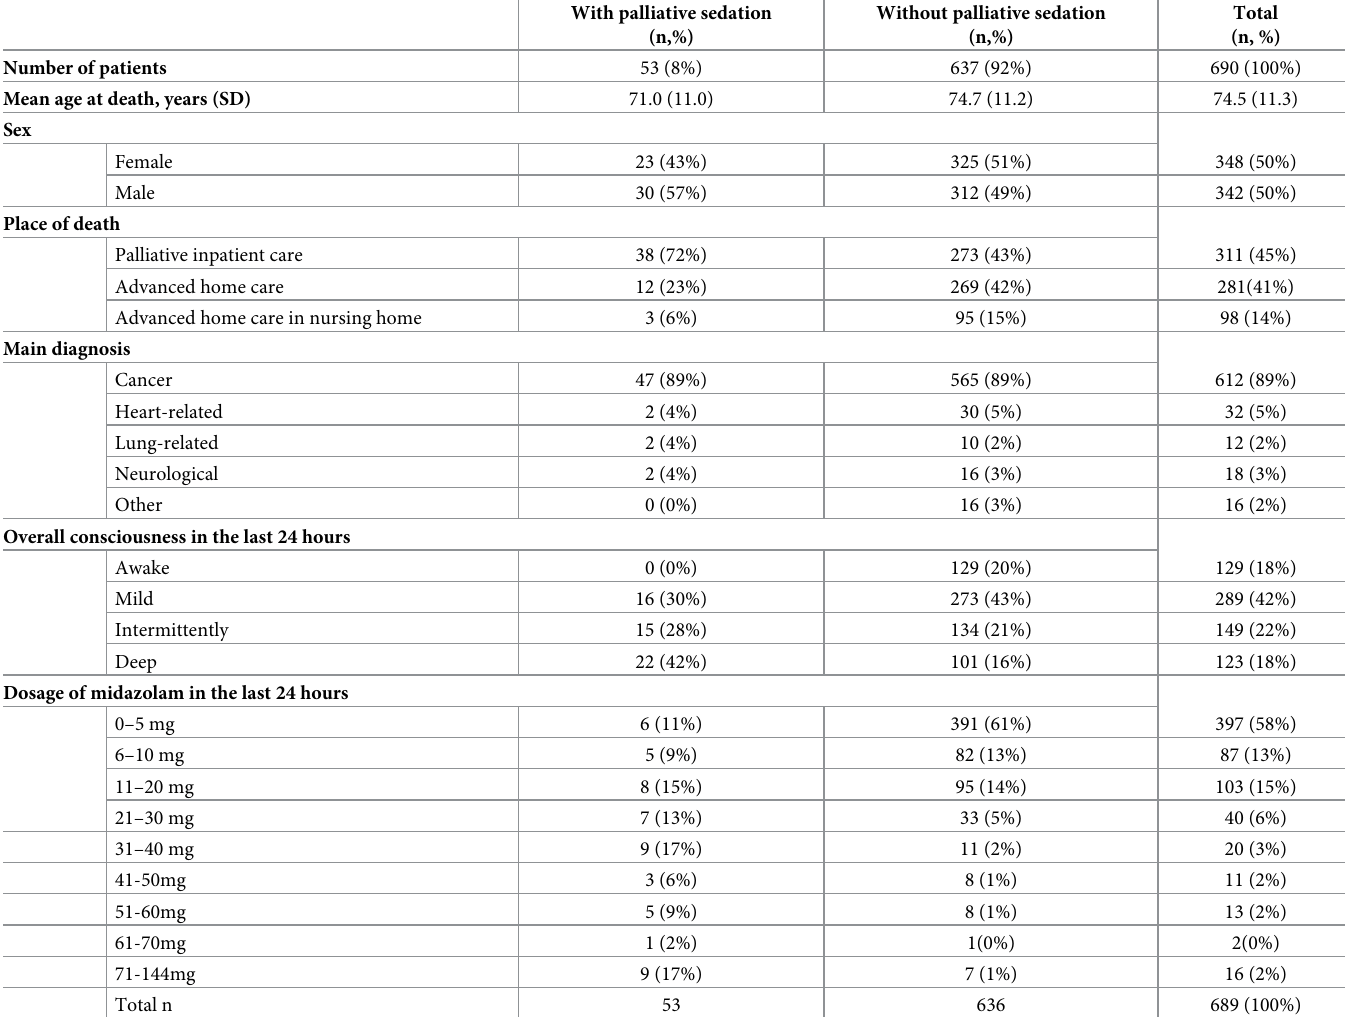
Table 1. Demographic data on the total patient group as well as patients with and without palliative sedation.